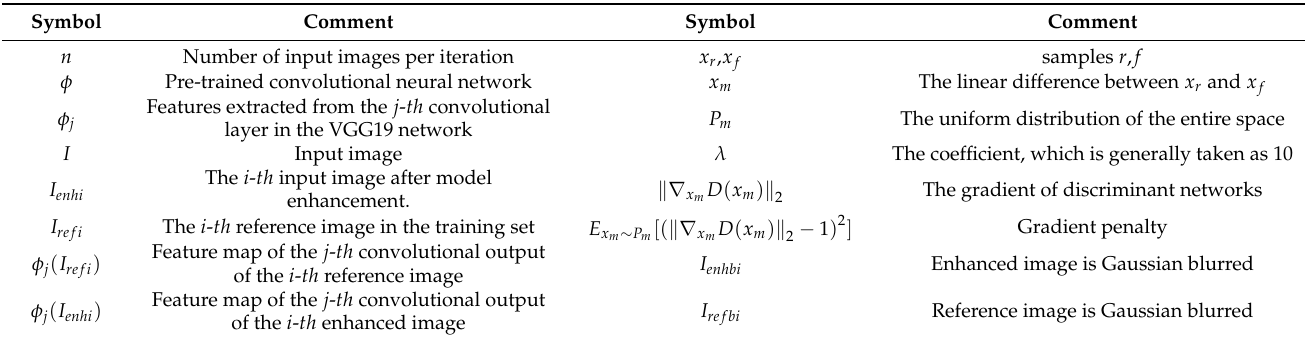
Table 4. Parameters in the mechanical